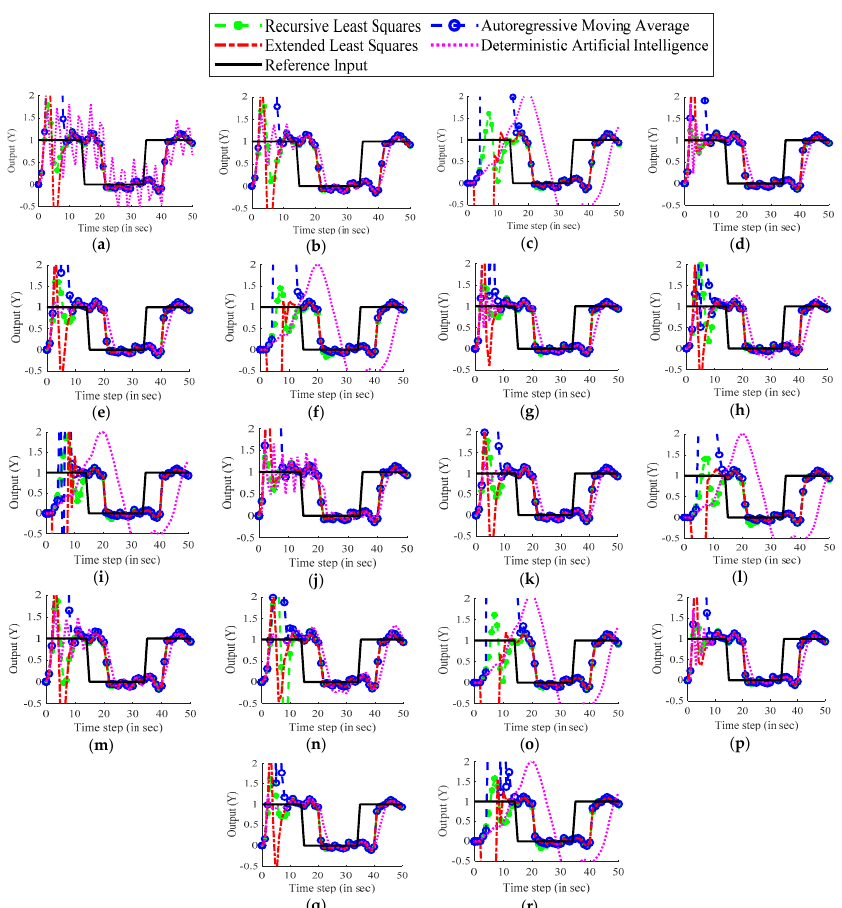
Figure 6. Output plot for each of the four control strategies with different discretization methods and sample time. ( a ) zero-order hold with 0.6 second sample time, ( b ) zero-order hold with 0.5 second sample time, ( c ) zero-order hold with 0.1 second sample time, ( d ) first-order hold with 0.7 second sample time, ( e ) first-order hold with 0.5 second sample time, ( f ) first-order hold with 0.1 second sample time, ( g ) impulse-invariant mapping with 0.5 second sample time, ( h ) im- pulse-invariant mapping with 0.3 second sample time, ( i ) impulse-invariant mapping with 0.1 second sample time, ( j ) Tustin approximation with 0.8 second sample time, ( k ) Tustin approxima- tion with 0.5 second sample time, ( l ) Tustin approximation with 0.1 second sample time, ( m ) ze- ro-pole matching with 0.5 second sample time, ( n ) zero-pole matching with 0.3 second sample time, ( o ) zero-pole matching with 0.1 second sample time, ( p ) least squares with 0.6 second sample time, ( q ) least squares with 0.5 second sample time, ( r ) least squares with 0.1 second sample time.